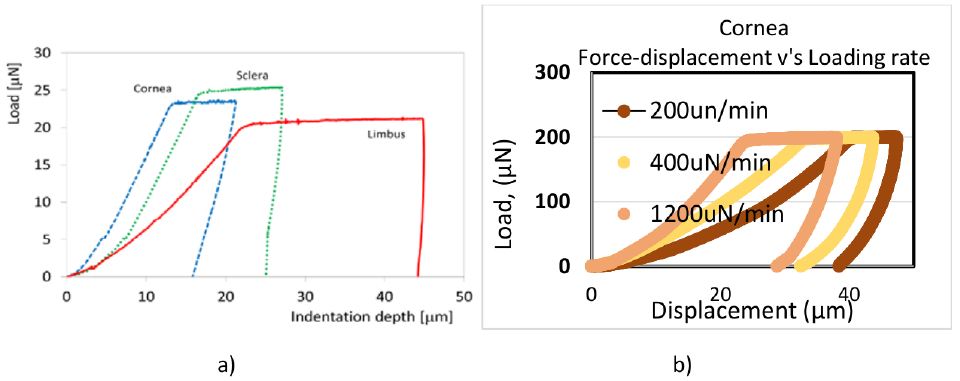
Figure 9. Force-displacement curves during the indentation of various regions of the external surface of the eye [60]. These force-displacement curves are also strongly loading rate